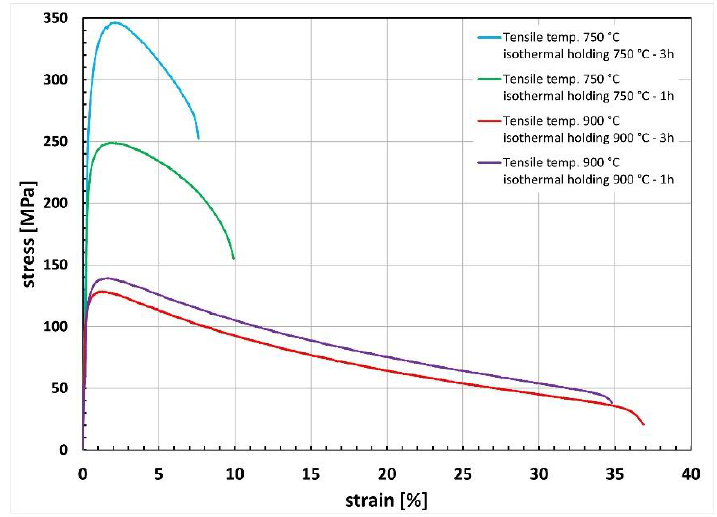
Figure 12. Characteristics of the stress – strain curves obtained at 750 °C and 900 °C for samples after solution heat treatment at 1080 °C and isothermal holding at 750 °C and 900 °C for 1 h and 3 h.